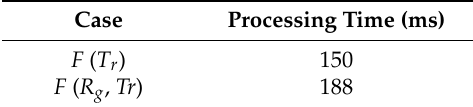
Table 4. Processing speed of the proposed algorithm.